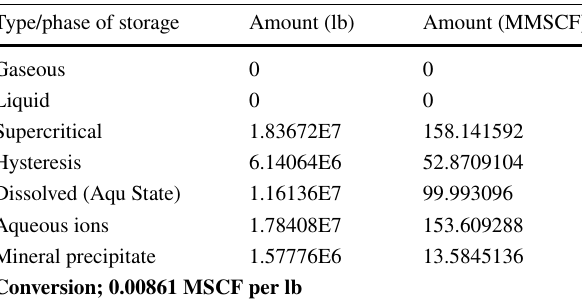
Fig. 11 Illustration of the mass of carbon dioxide stored within the formation for each trapping mechanism Table 7 Total amounts of carbon dioxide trapped within the reservoir of each corresponding trapping